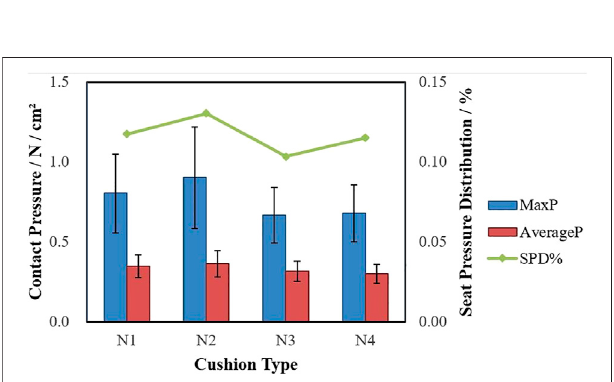
FIGURE 6 | The mean contact pressure ± SD for 20 participants in the four types of